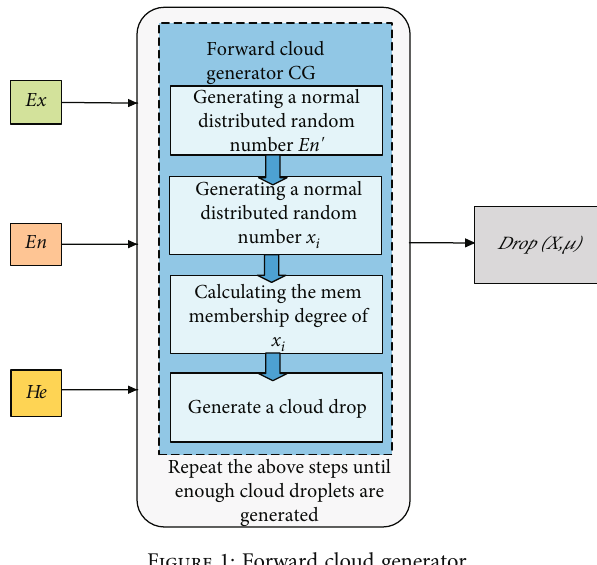
Figure 1: Forward cloud